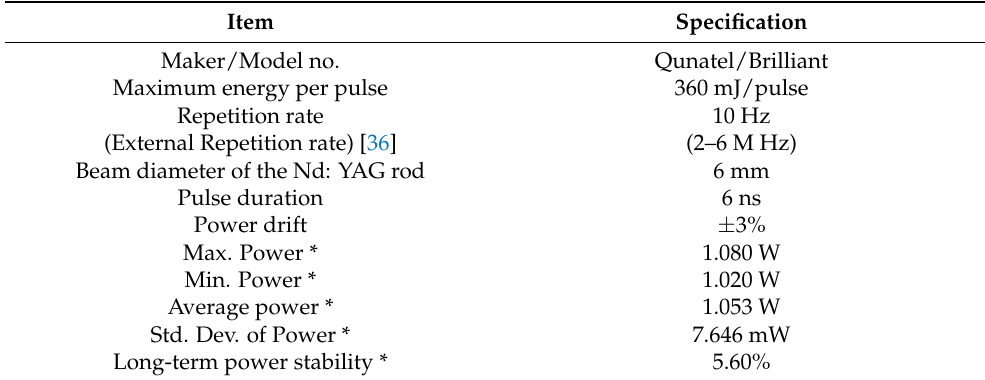
Table 1. Specifications of the Nd: YAG